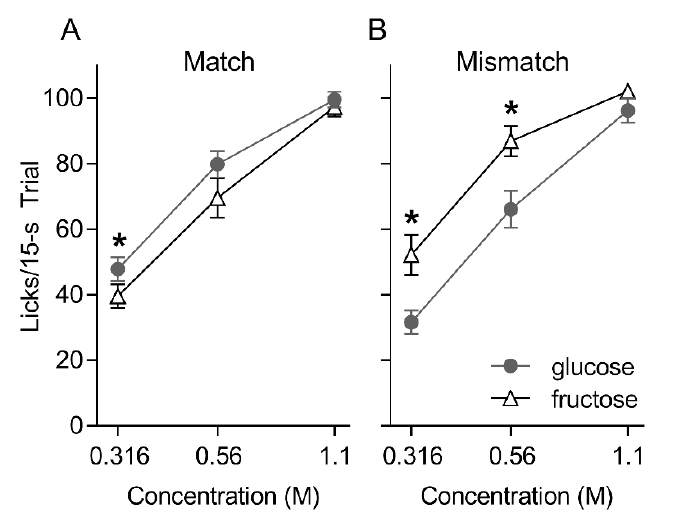
Figure 1. Mean ± SEM licks to three concentrations of glucose and fructose presented in randomized order in 15 s trials for the Matched ( A ) and Mismatched ( B ) training groups during the post-conditioning brief access taste test. Asterisks (*) indicate significant pair-wise differences (glucose versus fructose) at that concentration.